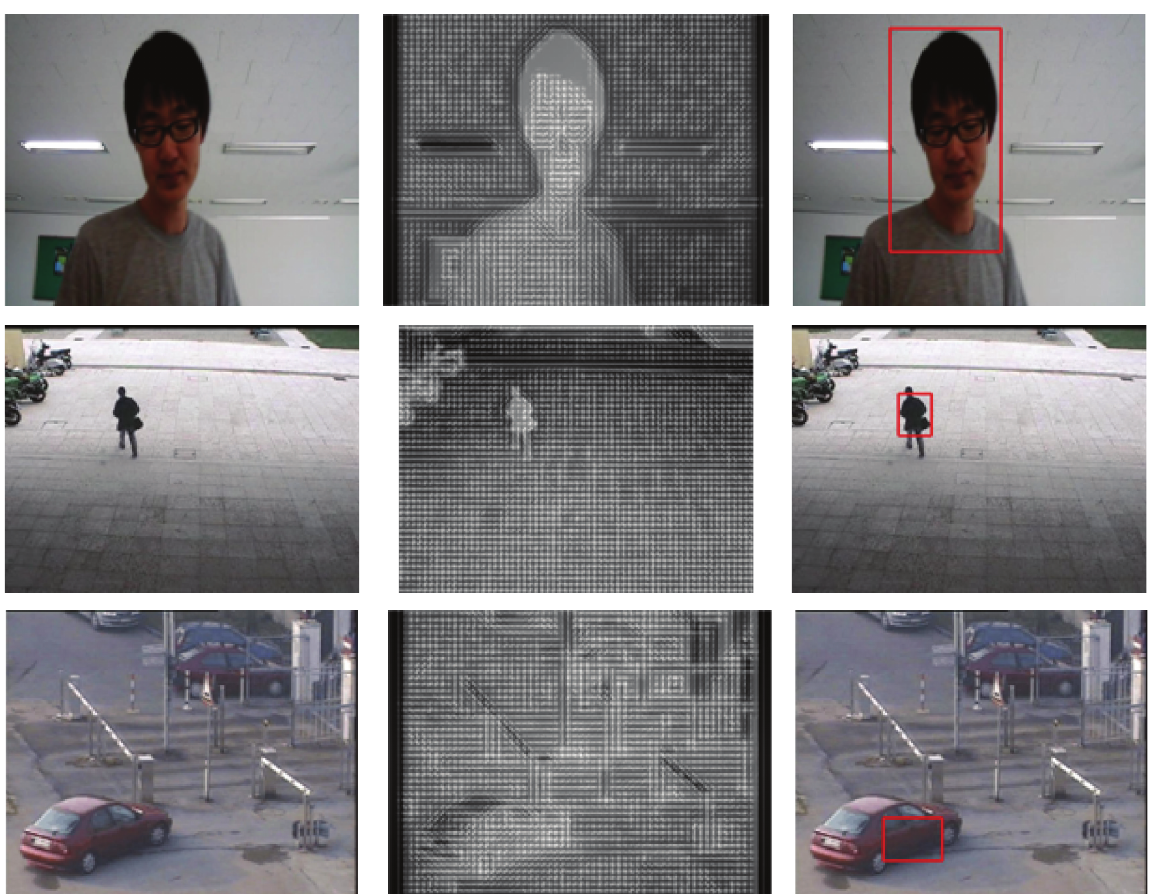
Figure 17: Videos (1), (2), and (3): results of integrating modified frequency tuned spatial model I with histogram of oriented gradient (HOG)